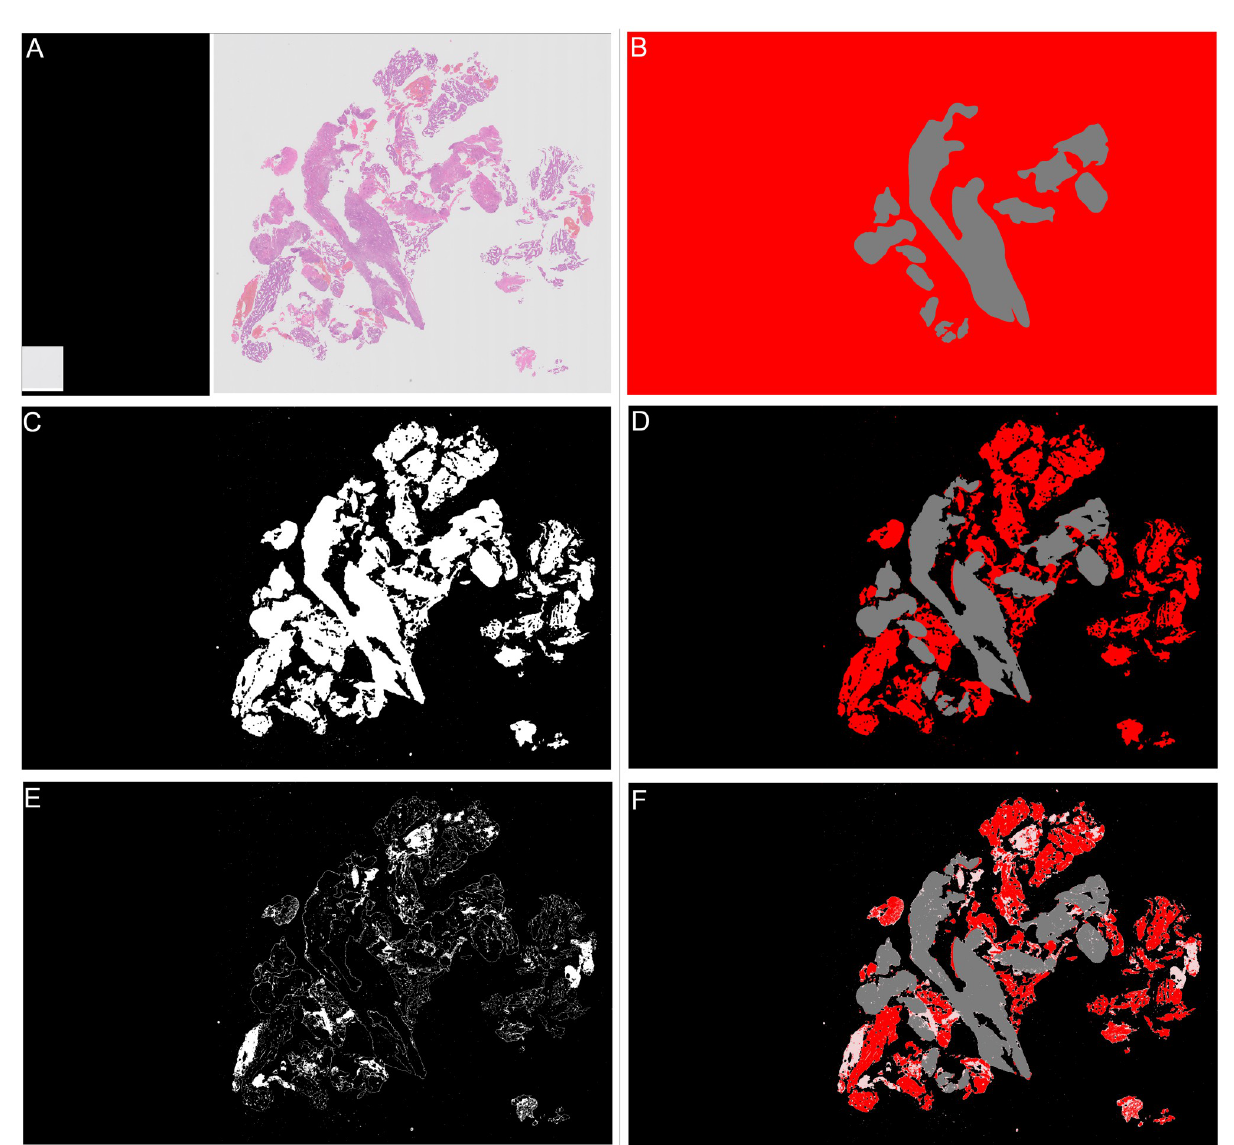
Fig 4. Examples of all stages in slide annotation and detection of tissue. Grey areas show “other or benign” category, red areas show “malignant” category. (A) Thumbnail of “malignant” slide where some tissue is “other or benign”. (B) Annotation for “malignant” slide where some tissue is “other or benign”. (C) Mask showing areas detected as tissue in white, background is shown in black. (D) Combined annotation and tissue detection, black is background, grey is “other or benign”, red is “malignant”. (E) Calculated mask showing areas detected as “blood or mucus” in white, anything that is not “blood or mucus” is shown as black. (F) Combined annotation, tissue and “blood or mucus” detection, black is background, pink is “blood or mucus”, grey is “other or benign”, red is